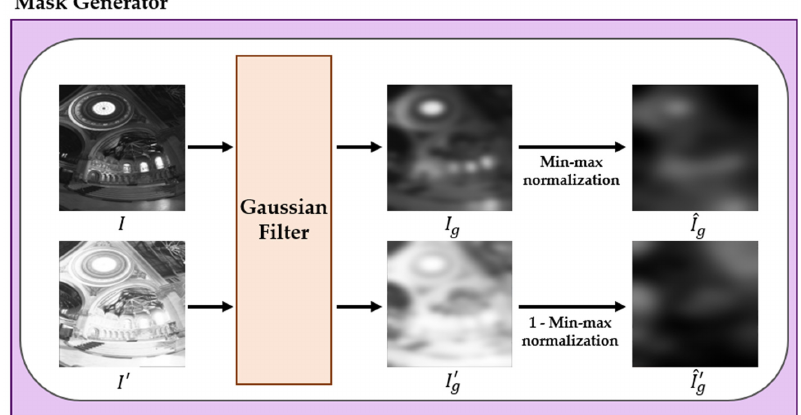
Figure 6. Detailed structure of the proposed MaskBuilder.